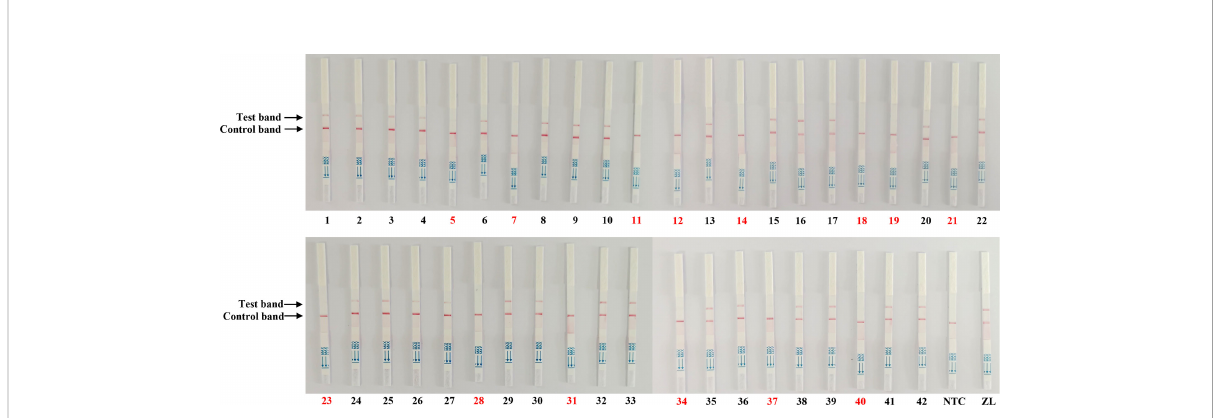
FIGURE 5 Clinical sample detection by the Cas13a lateral fl ow detection. The samples marked with black and red numbers are PEDV-positive and PEDV- negative samples, respectively. Forty-two samples were used for testing. ZL, pMD19T-ORF3 standard plasmid and NTC, negative